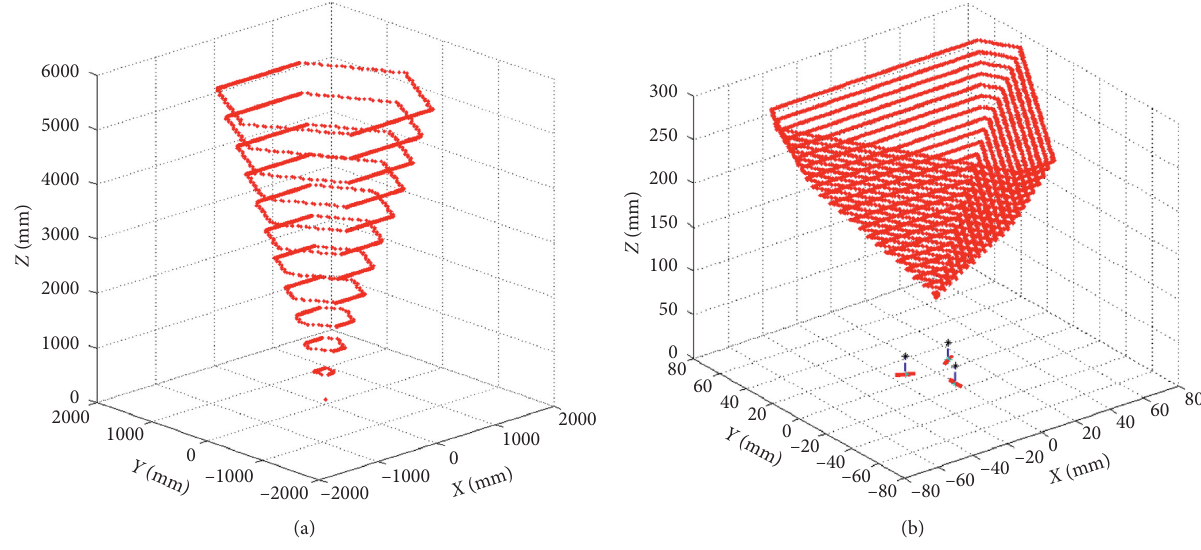
Figure 6: Measurable range of the sensor multilayer plane. (a) Z � {100, 600, . .. , 6000}. (b) Z � {90, 100, ... ,